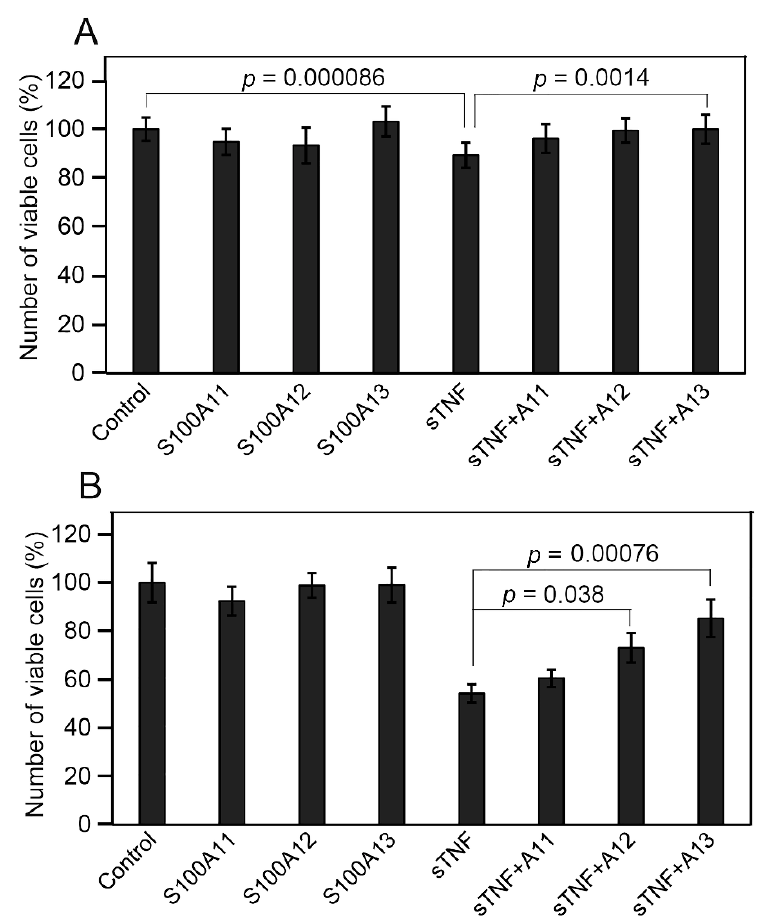
Figure 4. The effect of extracellular sTNF/S100A11/A12/A13 (6 nM and 9 nM for sTNF and S100, respectively) and their combinations on the viability of Huh-7 cells, measured by MTT assay. The untreated cells served as a control. ( A ) The cells were cultured with the S100 proteins either in the absence or presence of sTNF, as indicated. ( B ) The same experiments performed in the presence of 10 µ g/mL CHX to block the sTNF-induced survival pathways. The data represent the mean values from at least four independent experiments performed in quadruplicates. The errors correspond to standard deviations. The p -values were calculated according to Student’s t -test.